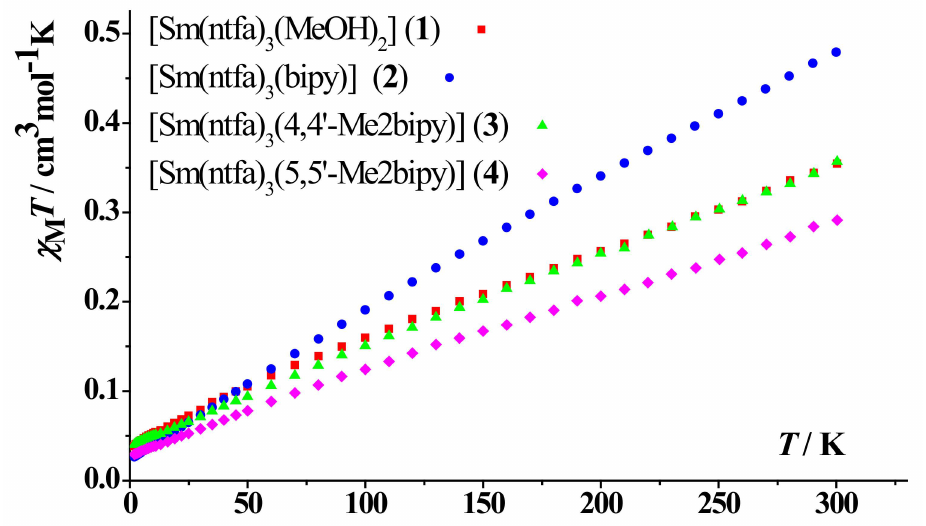
Figure 6. χ M T vs. T plots for compounds 1 – 4